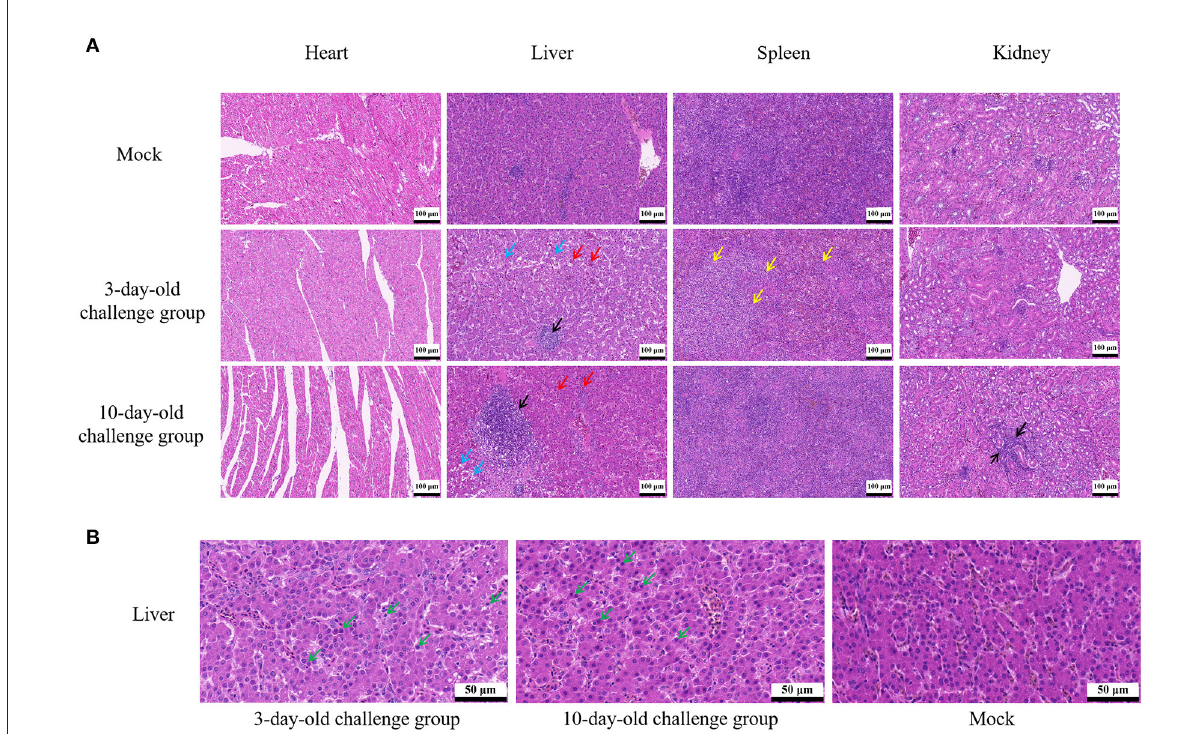
FIGURE7 Histopathological analysis of FAdV-2 strain GX01. (A) Histopathological analysis showed massive infiltration of inflammatory cells was observed in liver and kidney of infected chickens (black arrow); Congested in liver sinuses (red arrow); Hepatocyte vacuolar degeneration with small vacuoles visible in the cytoplasm (blue arrow); Massive lymphocyte necrosis in red-white pith of spleen (yellow arrow). (B) Typically inclusion body was observed in liver (green arrow).